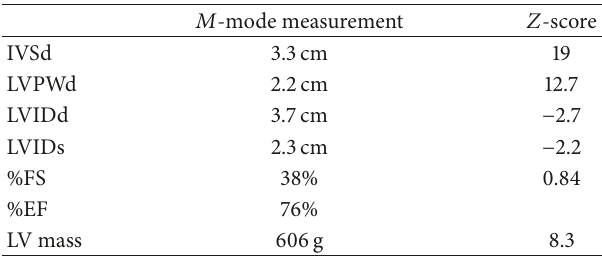
Table 1: Echocardiographic assessment on the recent admission (17 years